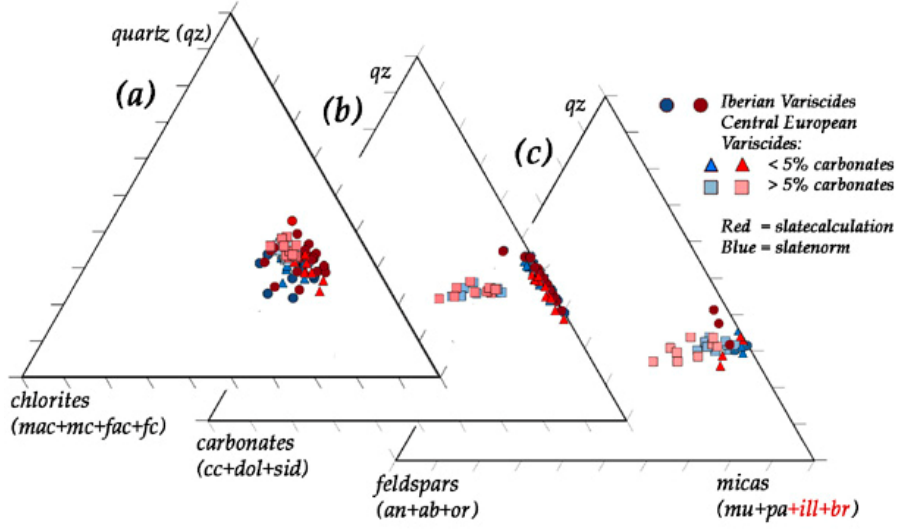
Figure 9. Comparison of the main minerals calculated with slatenorm (blue) and slatecalculation (red). ( a ) quartz/micas/chlorites, ( b ) quartz/micas/carbonates, ( c ) quartz/micas/feldspars.